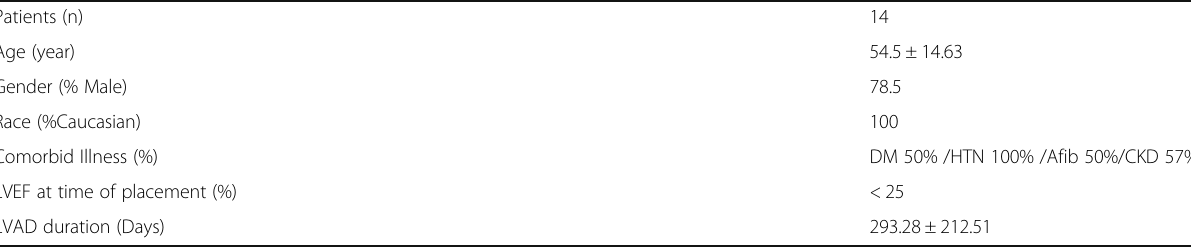
Table 1 Heart Failure Patient Characteristics Patients